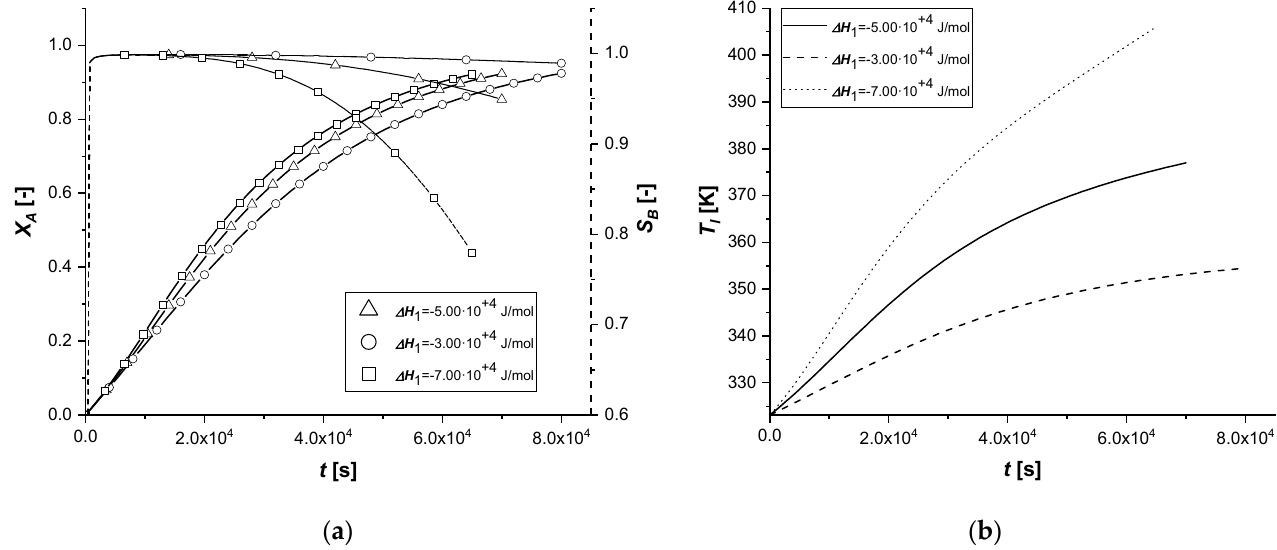
Figure 6. EW Δ rH 1 investigation. ( a ) Bulk profiles over time of X A and S B . ( b ) Bulk profile of T l over time.